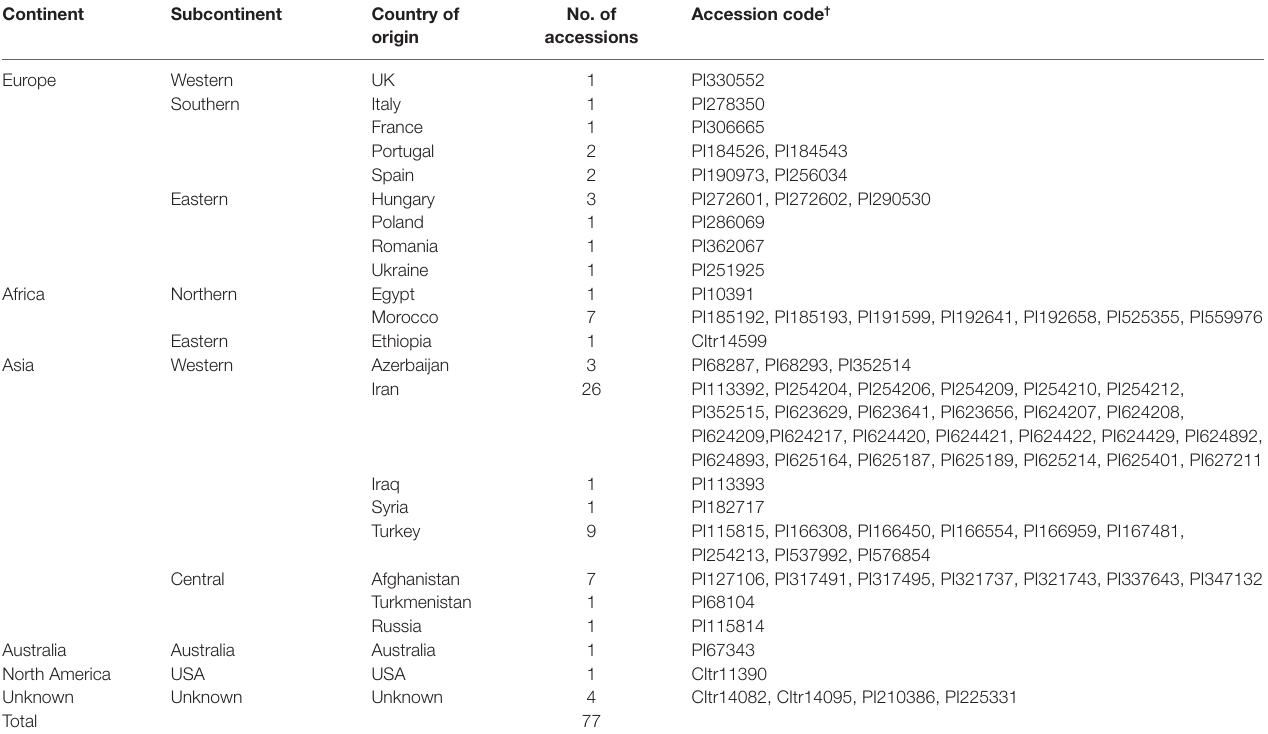
TABLe 1 | The 77 germplasm accessions of Khorasan wheat used for the evaluation (collection